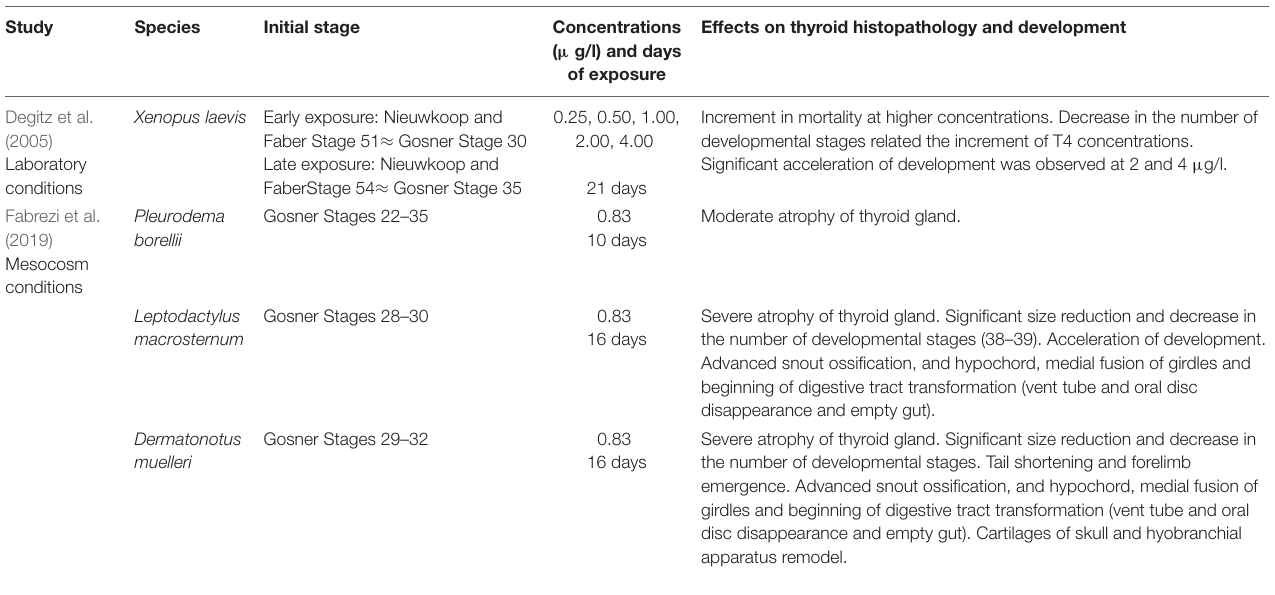
TABLE 2 | Comparison of studies of larval development of anuran species exposed to